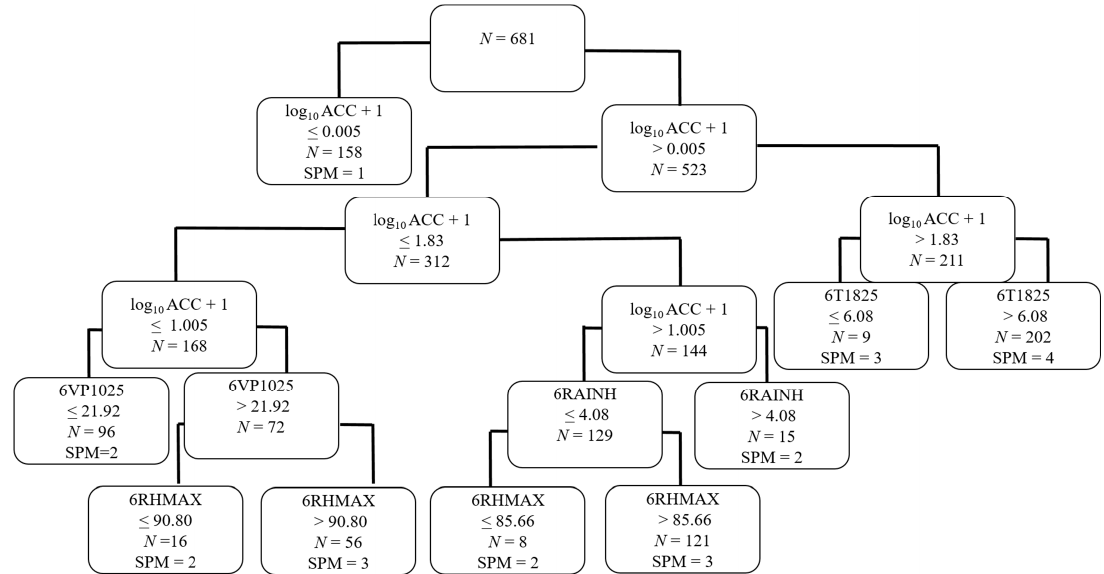
Figure 5. Representation of the classification tree built with airborne inoculum concentration (log 10 ACC + 1), mean number of hours at temperature between 18 and 25 °C during the previous six days (6T1825), mean maximum % relative humidity during the previous six days (6RHMAX), mean number of hours at saturation vapor pressure between 10 and 25 mmHg during the previous six days (6VP1025), and mean number of rainy hours during the previous six days (6RAINH).